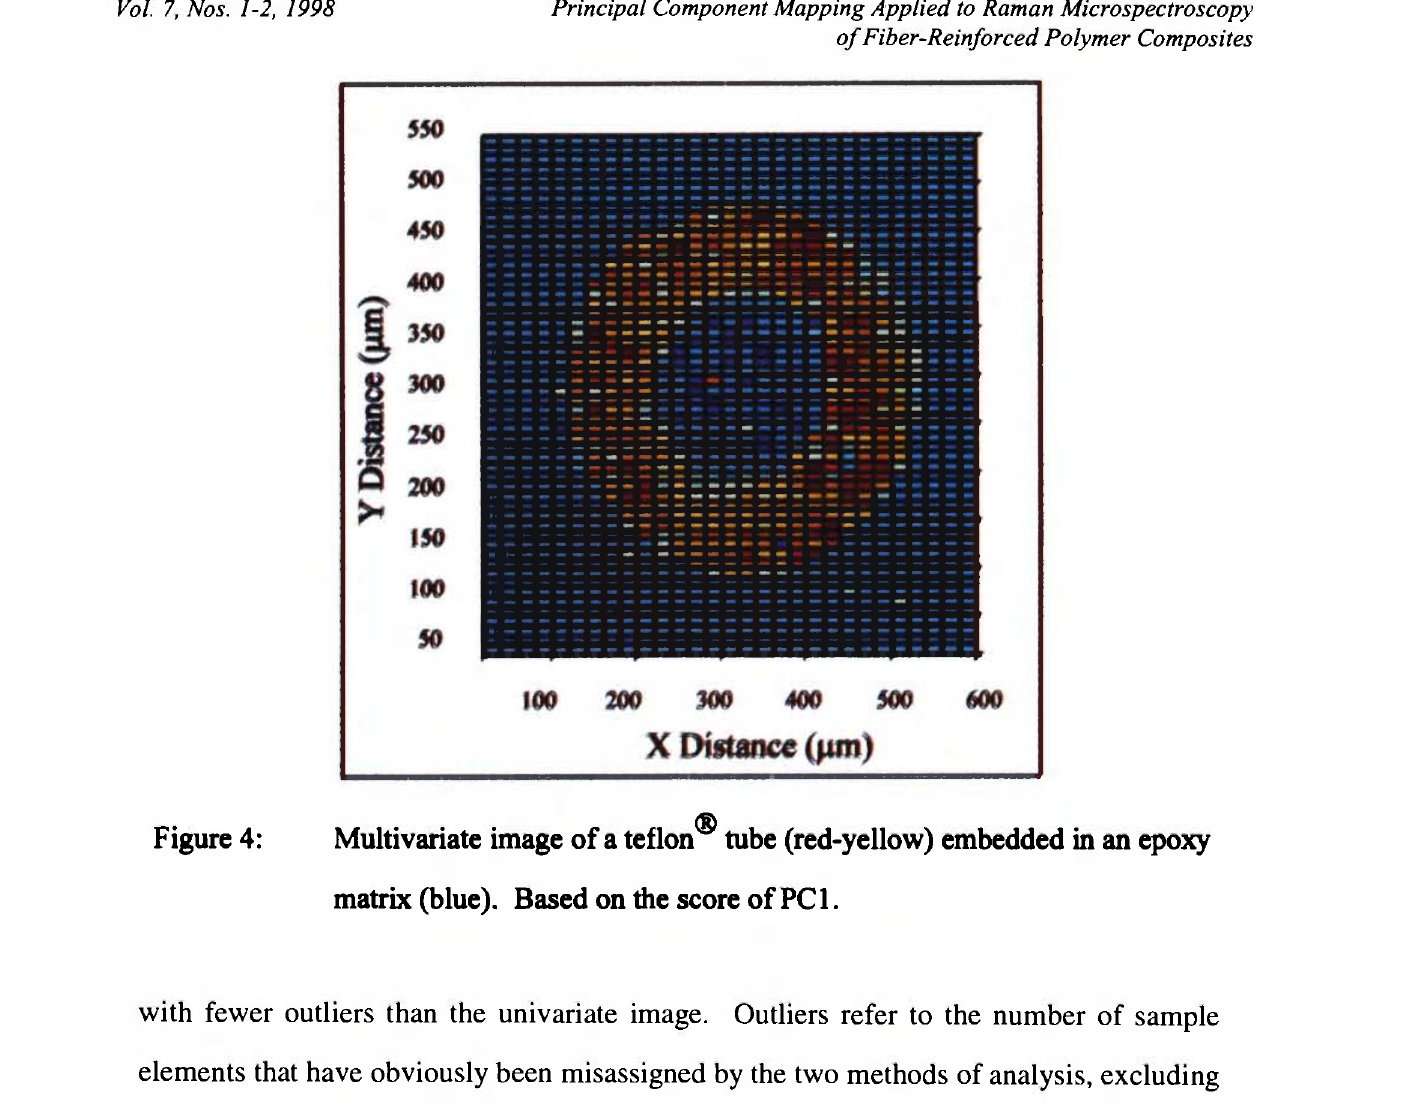
® Figure 4: Multivariate image of a teflon tube (red-yellow) embedded in an epoxy matrix (blue). Based on the score of PCI. with fewer outliers than the univariate image. Outliers refer to the number of